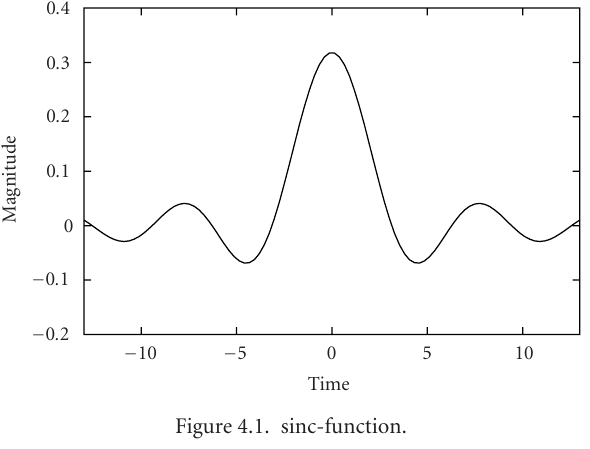
Figure 4.1. sinc-function.